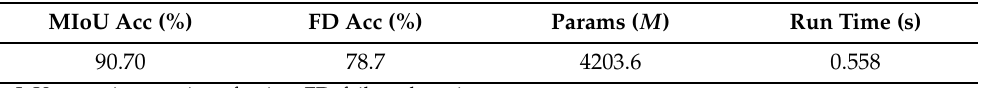
Table 11. mIoU prediction and failure detection accuracy for